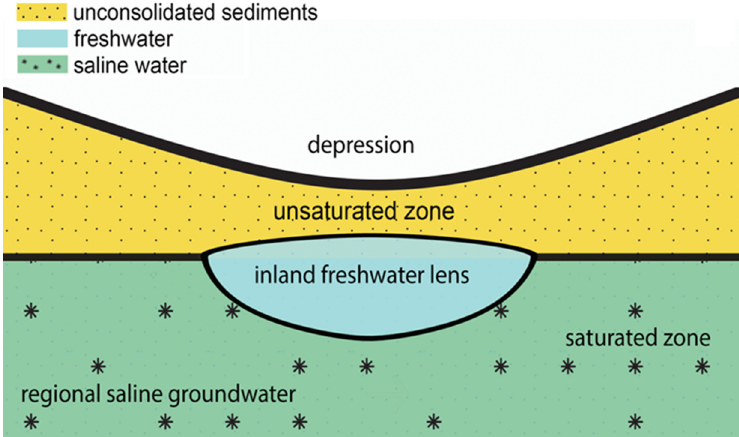
Figure 1. Conceptual diagram of an inland freshwater lens (IFL). Modified from Rotz and Milewski [1] .